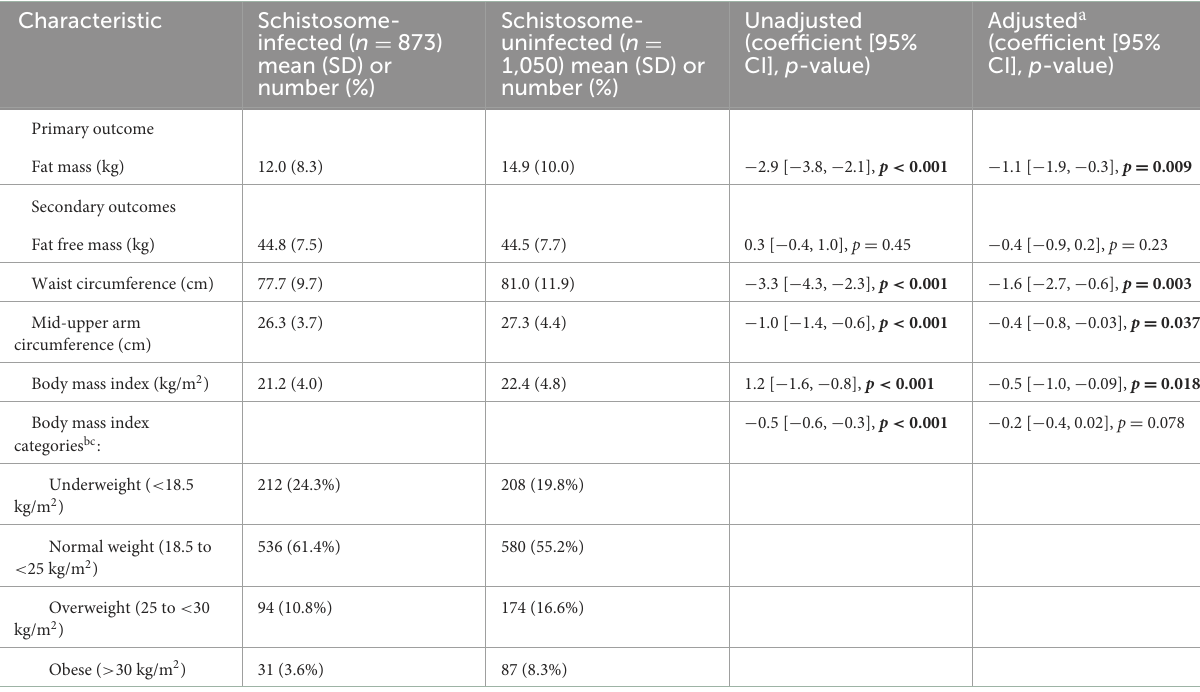
TABLE 2 Measures of adiposity and body composition in schistosome-infected vs. uninfected individuals. Characteristic